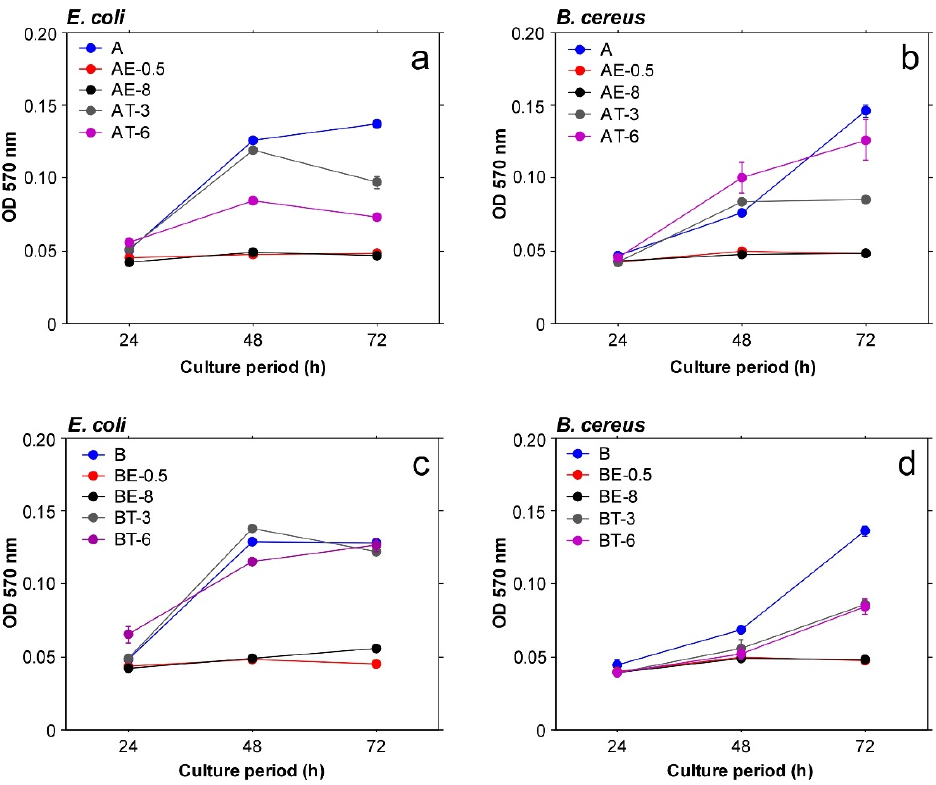
Figure 9. Relative levels of viable E. coli ( a , c ) and B. cereus ( b , d ) bacteria during different culture periods in the presence of test specimens.